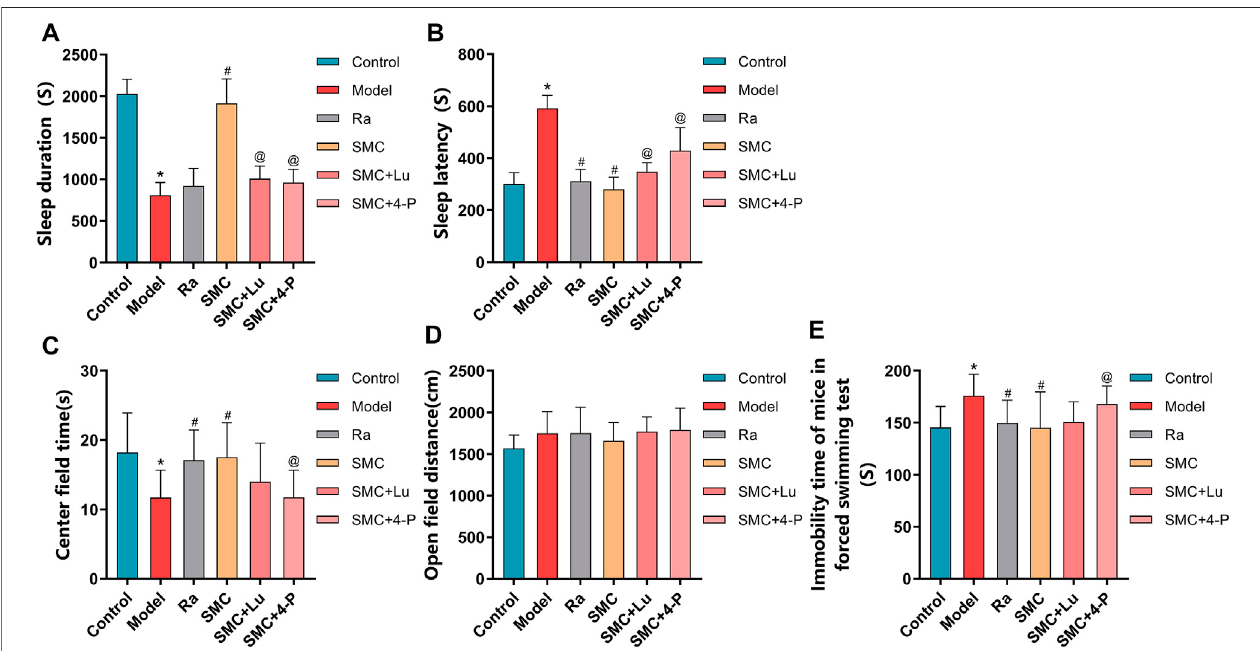
FIGURE 7 | Behavioral experimental indexes of sleep-deprived mice after being treated with ramelteon, SMC, luzindole, and 4-P-PDOT ( n = 12 – 14). (A) Sleep duration. (B) Sleep latency. (C) Center fi eld time of OFT. (D) Open- fi eld distance of OFT. (E) Immobility time of FST. * p < 0.05 vs. Control group; # p < 0.05 vs . Model group; @ p < 0.05 vs . SMC group. All the data were represented as the mean ±